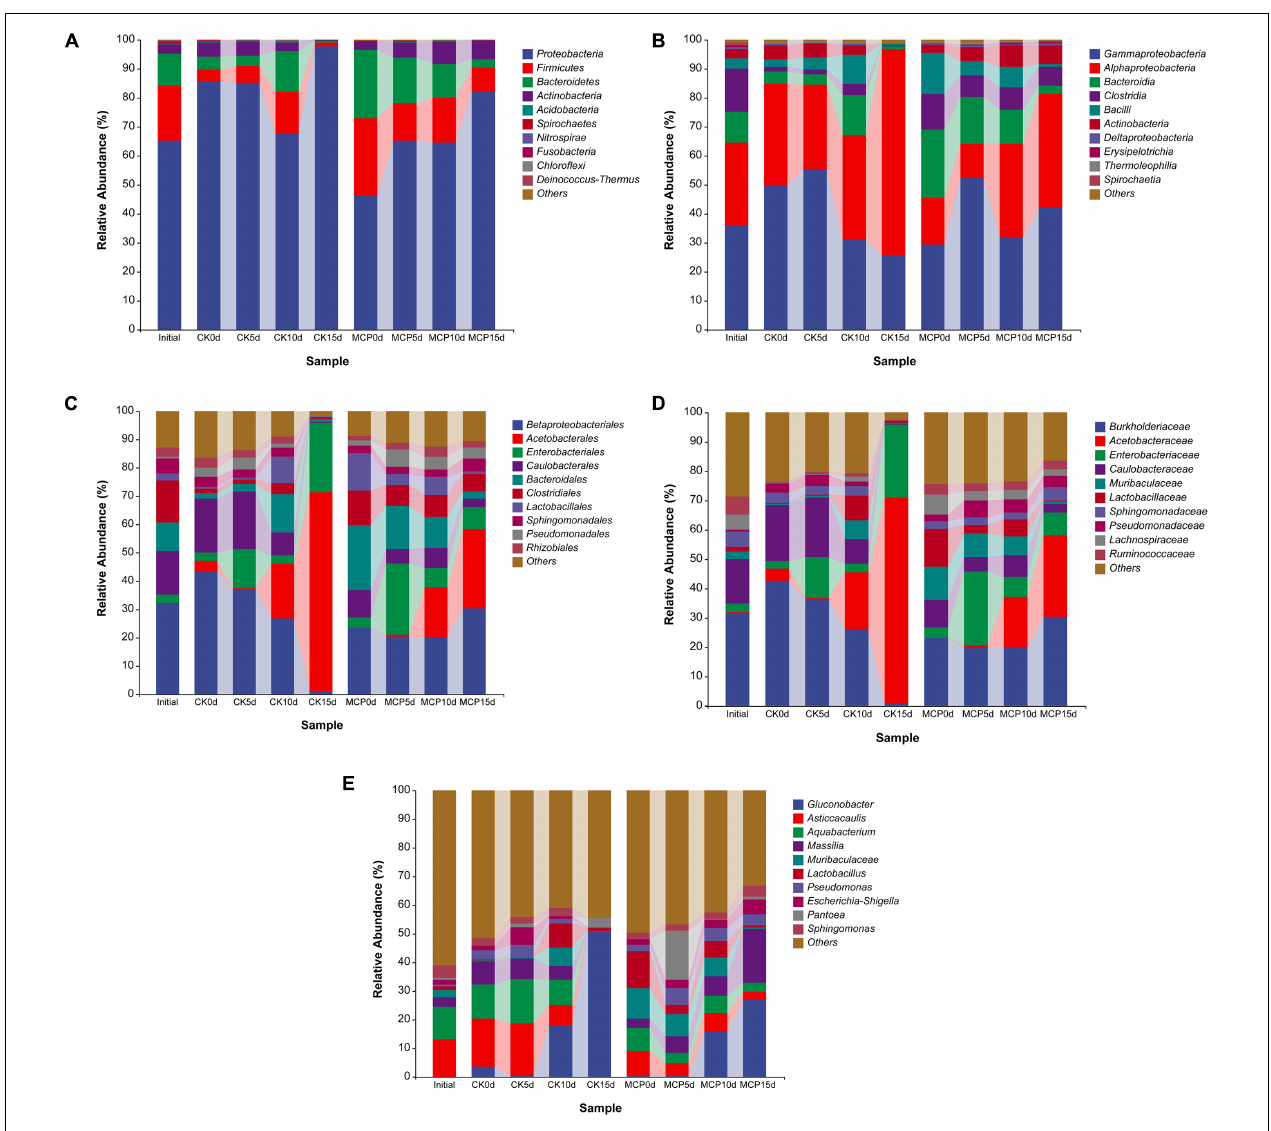
FIGURE 3 | Taxonomic composition of bacteria at phylum (A) , class (B) , order (C) , family (D) , and genus (E) levels. Pear ( Pyrus communis L. cv. “Doyenne du Comice”) fruits were treated with or without 1.0 µ l L − 1 of 1-MCP during storage. Fruits were stored at 25 ± 0.5 ◦ C and relative humidity of 90 ± 5% for 0, 5, 10, and 15 days. The treatments were marked as CK0d, CK5d, CK10d, and CK15d, representing fruit stored for 0, 5, 10, and 15 days in the control group, while MCP0d, MCP5d, MCP10d, and MCP15d represent fruits stored for 0, 5, 10, and 15 days in the 1-MCP-treated group,